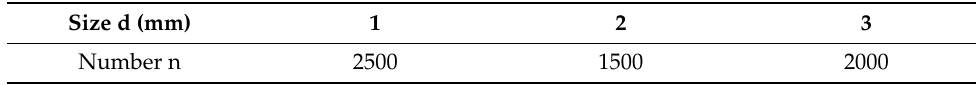
Table 5. 40 mm × 40 mm × 39 mm particle composition.